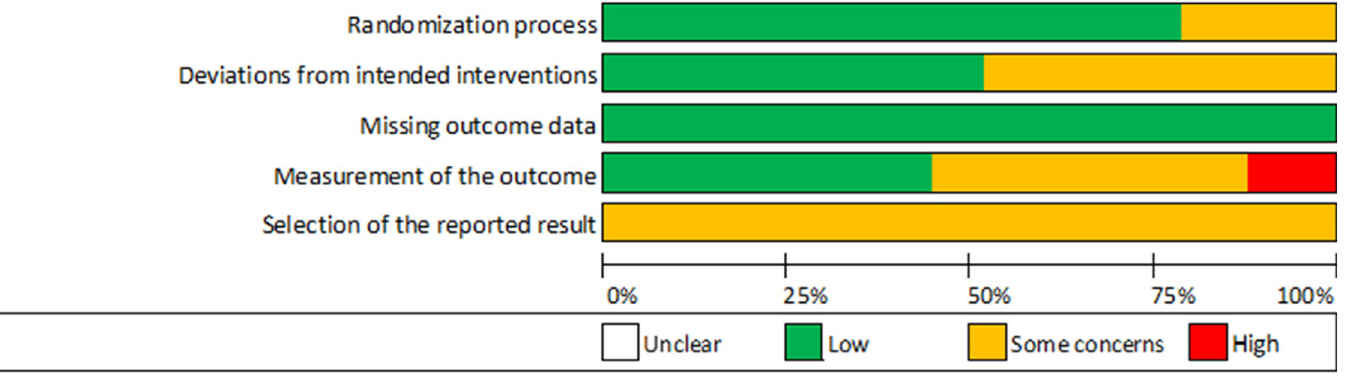
Fig 2. The proportions of risk of bias classifications for 42 outcomes